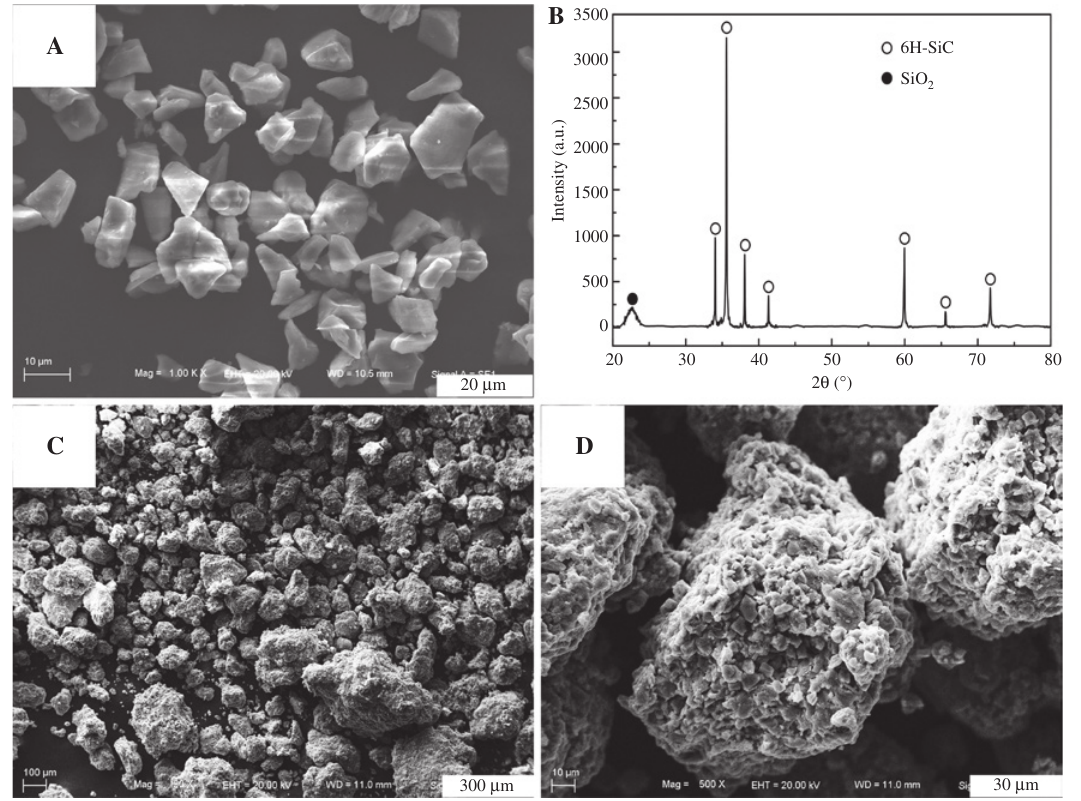
) composite particles milled by 96 h p